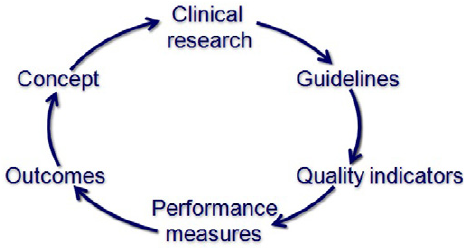
Figure. 7 Cycle of clinical research and quality improvement. Reproduced from Califf et al. [33] with